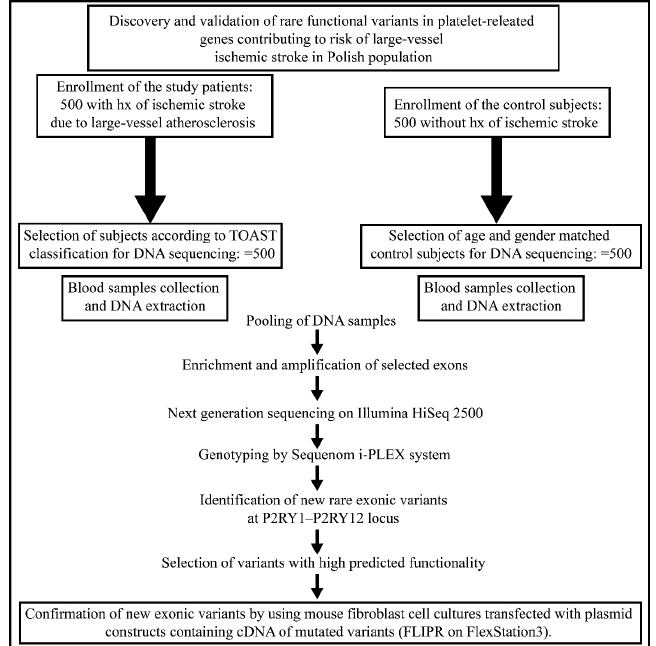
Figure 1. Study-flow diagram. TOAST; Trial of Org 10172 in Acute Stroke Treatment, hx; history.